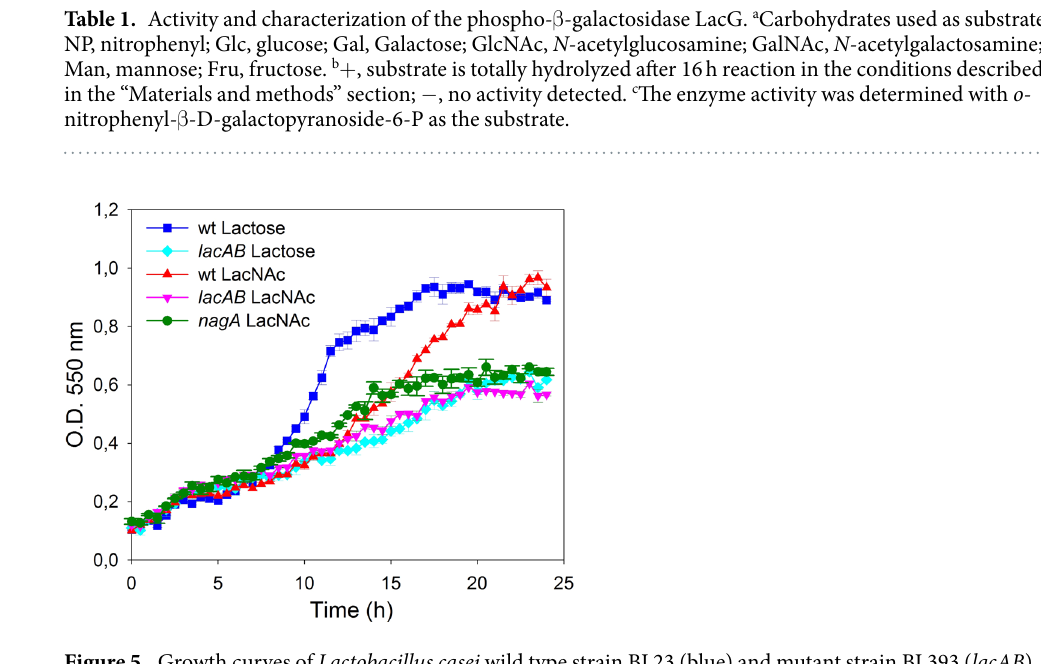
Figure 5. Growth curves of Lactobacillus casei wild type strain BL23 (blue) and mutant strain BL393 ( lacAB ) (cyan) on sugar-free MRS with lactose. BL23 (red) and mutants BL393 ( lacAB ) (pink) and BL388 ( nagA ) (green) on sugar-free MRS supplemented with N -acetyllactosamine (LacNAc). Data presented are mean values based on at least three replicates. Error bars indicate standard